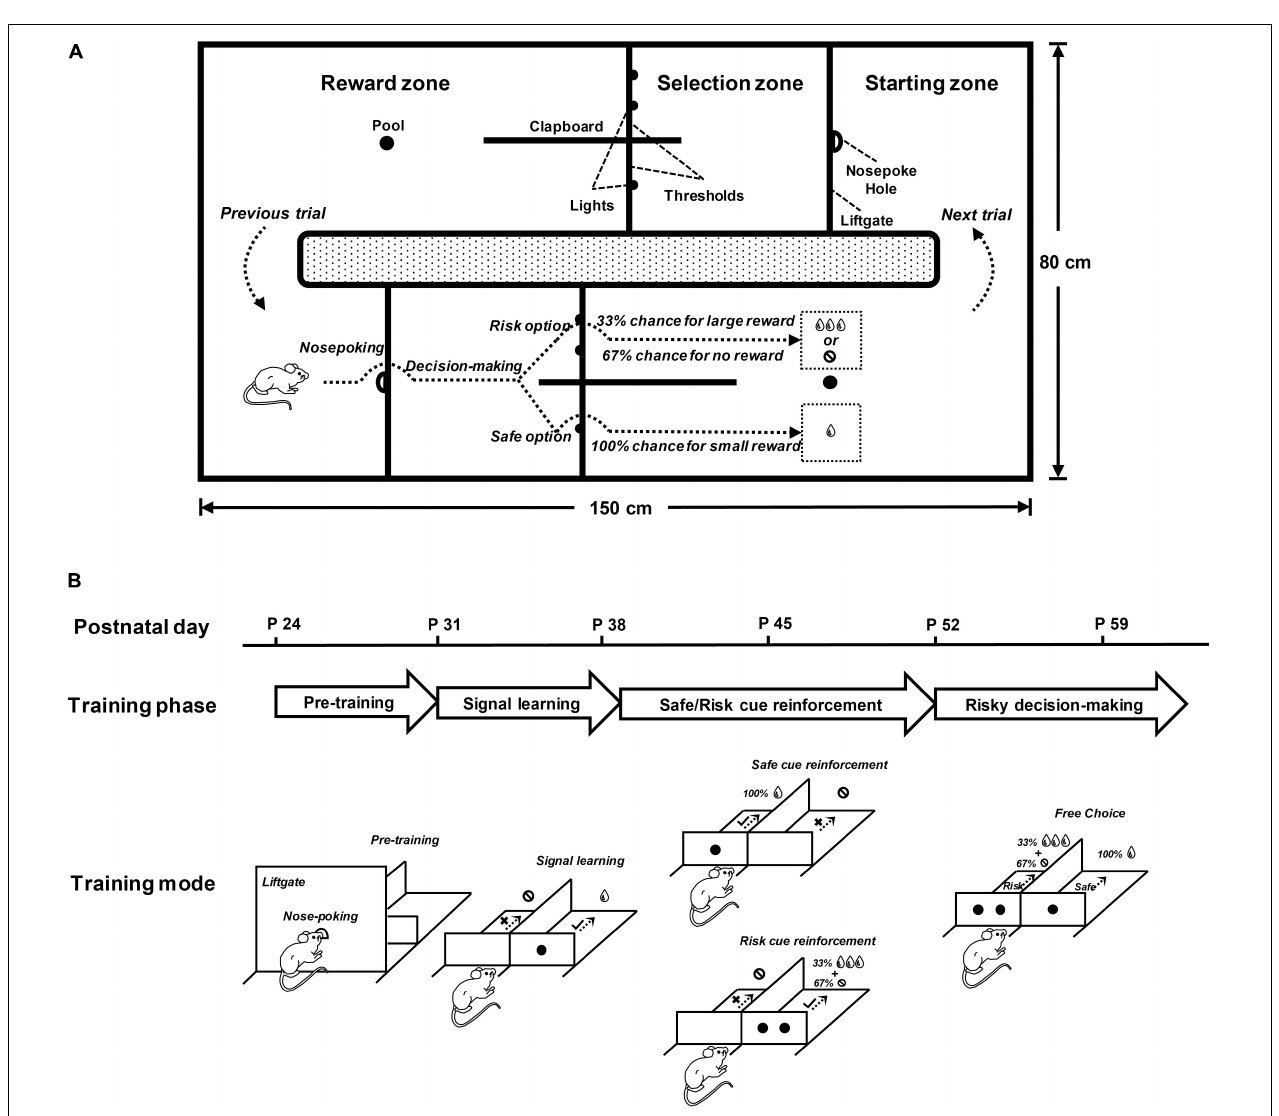
FIGURE 1 | The behavioral paradigm for rats to perform the cue-guided risky decision-making task (RDM). (A) This simplified top view shows the main structure of the RDM maze and the performance of a rat in the RDM task. The maze consisted of two identical training chambers placed end to end and was therefore a closed training loop for rats to perform in a naturalistic manner. The upper part of the diagram shows the key structure of the training chamber, outlined with solid lines and texts. The height of the chamber structures was 30 cm, except for the thresholds. The lower part of the diagram shows the behavioral operation of a rat in the training chamber, simulated by the dotted arrows and illustrated by the texts. After completing the operation in one chamber, rats were required to run counter clockwise to the starting zone of the other chamber to start the next trial. (B) Learning stages (pre-training, signal learning and safe/risk cue reinforcement) and testing stage (risky decision-making) for the RDM task. The time line shows the approximate points (postnatal day) at which the rats entered the corresponding stages. The simplified diagrams below show the training modes for each stage. In the pre-training stage, the rats were trained to initiate the task by nose poking and to move counter clockwise between the two chambers continuously. In the signal-learning stage, the rats were trained to pay attention to the signal on the threshold in the selection arm. In the safe/risk cue-reinforcement stage, the rats were trained to reinforce cues with rewards. In the risky decision-making stage, the rats were trained to freely make choices between the safe and risky